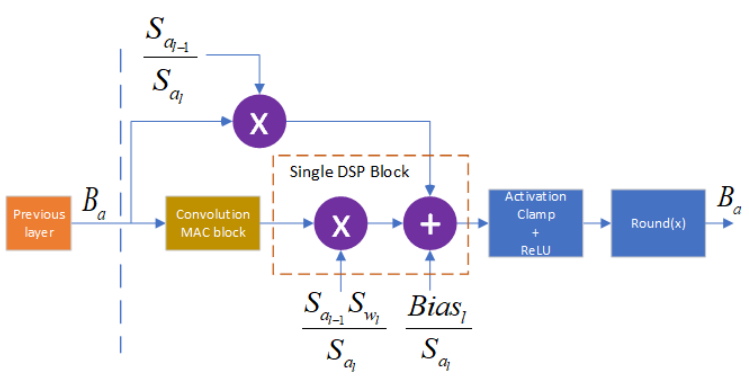
Figure 4. Residual block in